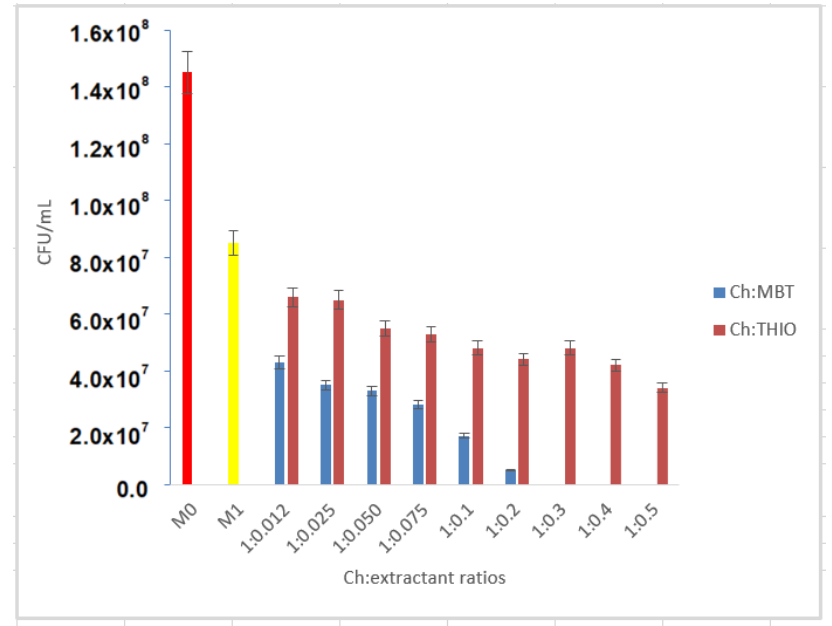
Figure 7. Comparison of control sample (M0)—Ch (M1)—Ch: functionalized with sulfur compound.